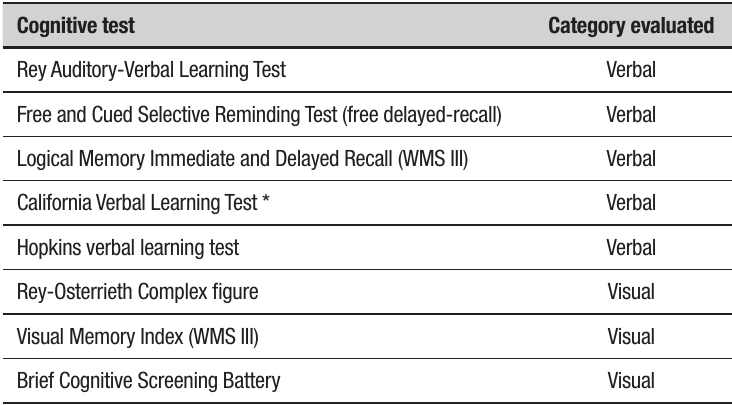
Table 1. Commonly used memory tests for the Brazilian population. Cognitive